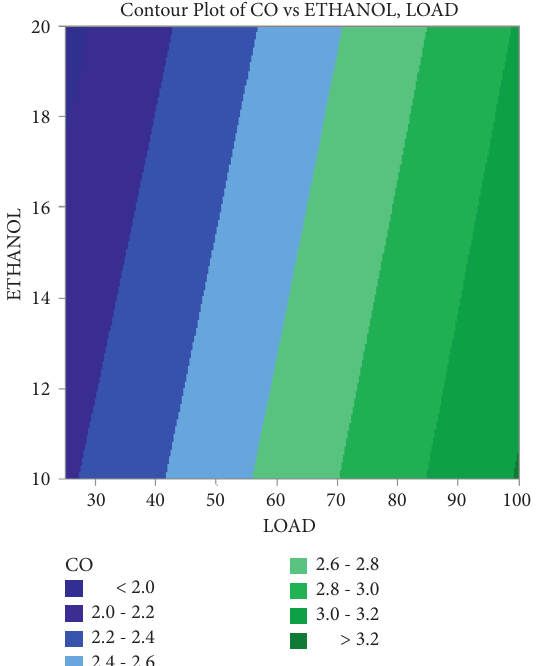
Figure 8: Contour plot of carbon monoxide on load and ethanol blend.